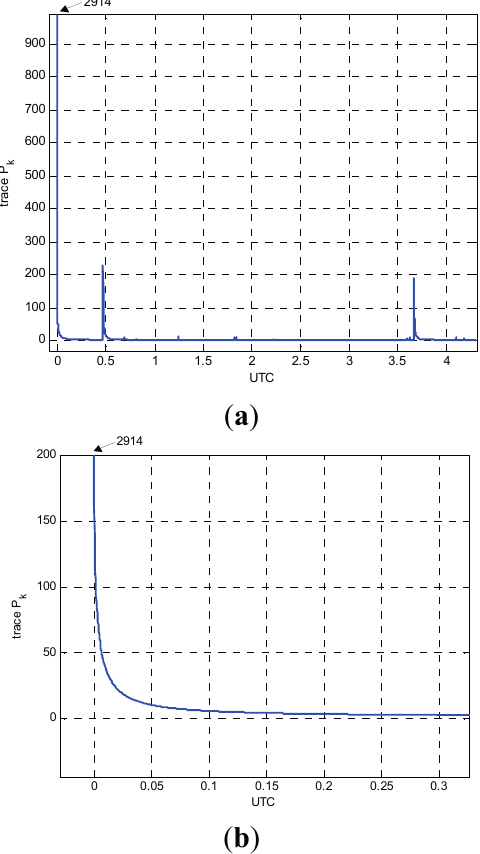
Figure 2. Convergence of the covariance matrix, P k : ( a ) whole trajectory; ( b ) beginning part of the